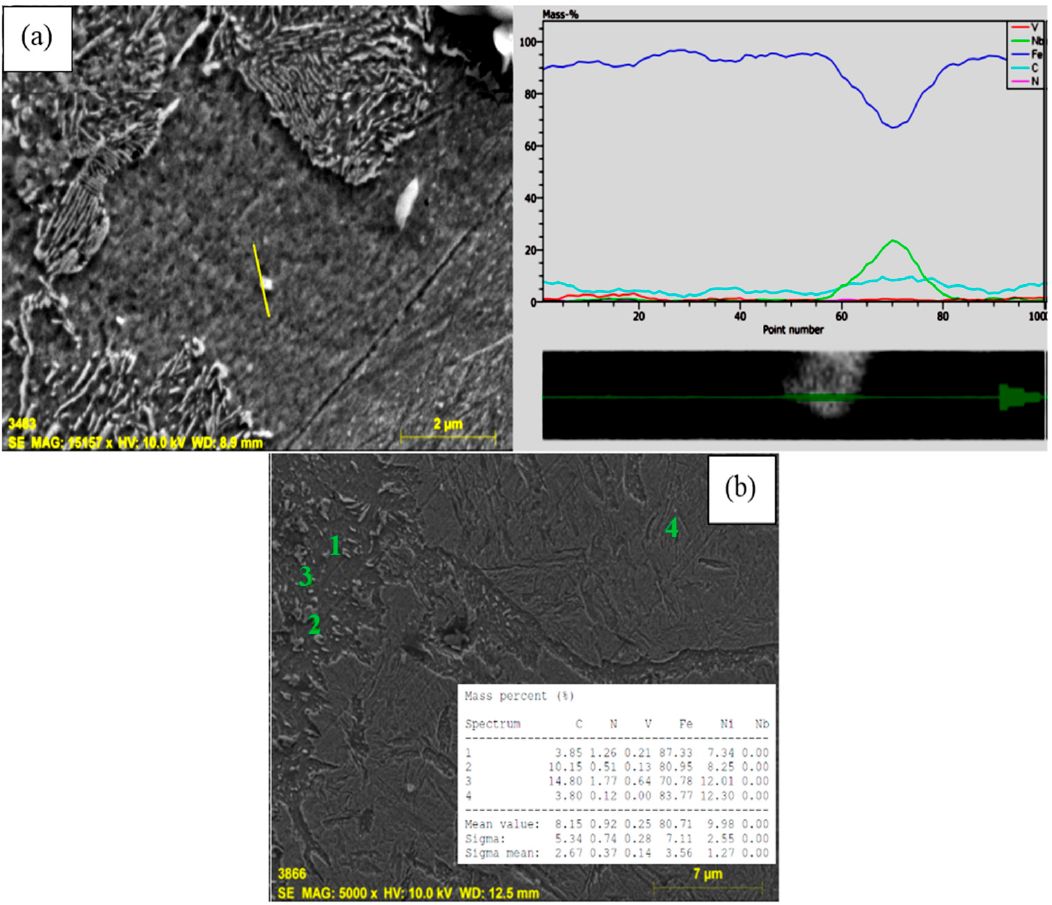
Figure 3. ( a ) SEM line EDS image of alloy 2 and ( b ) precipitates formed at grain boundaries.